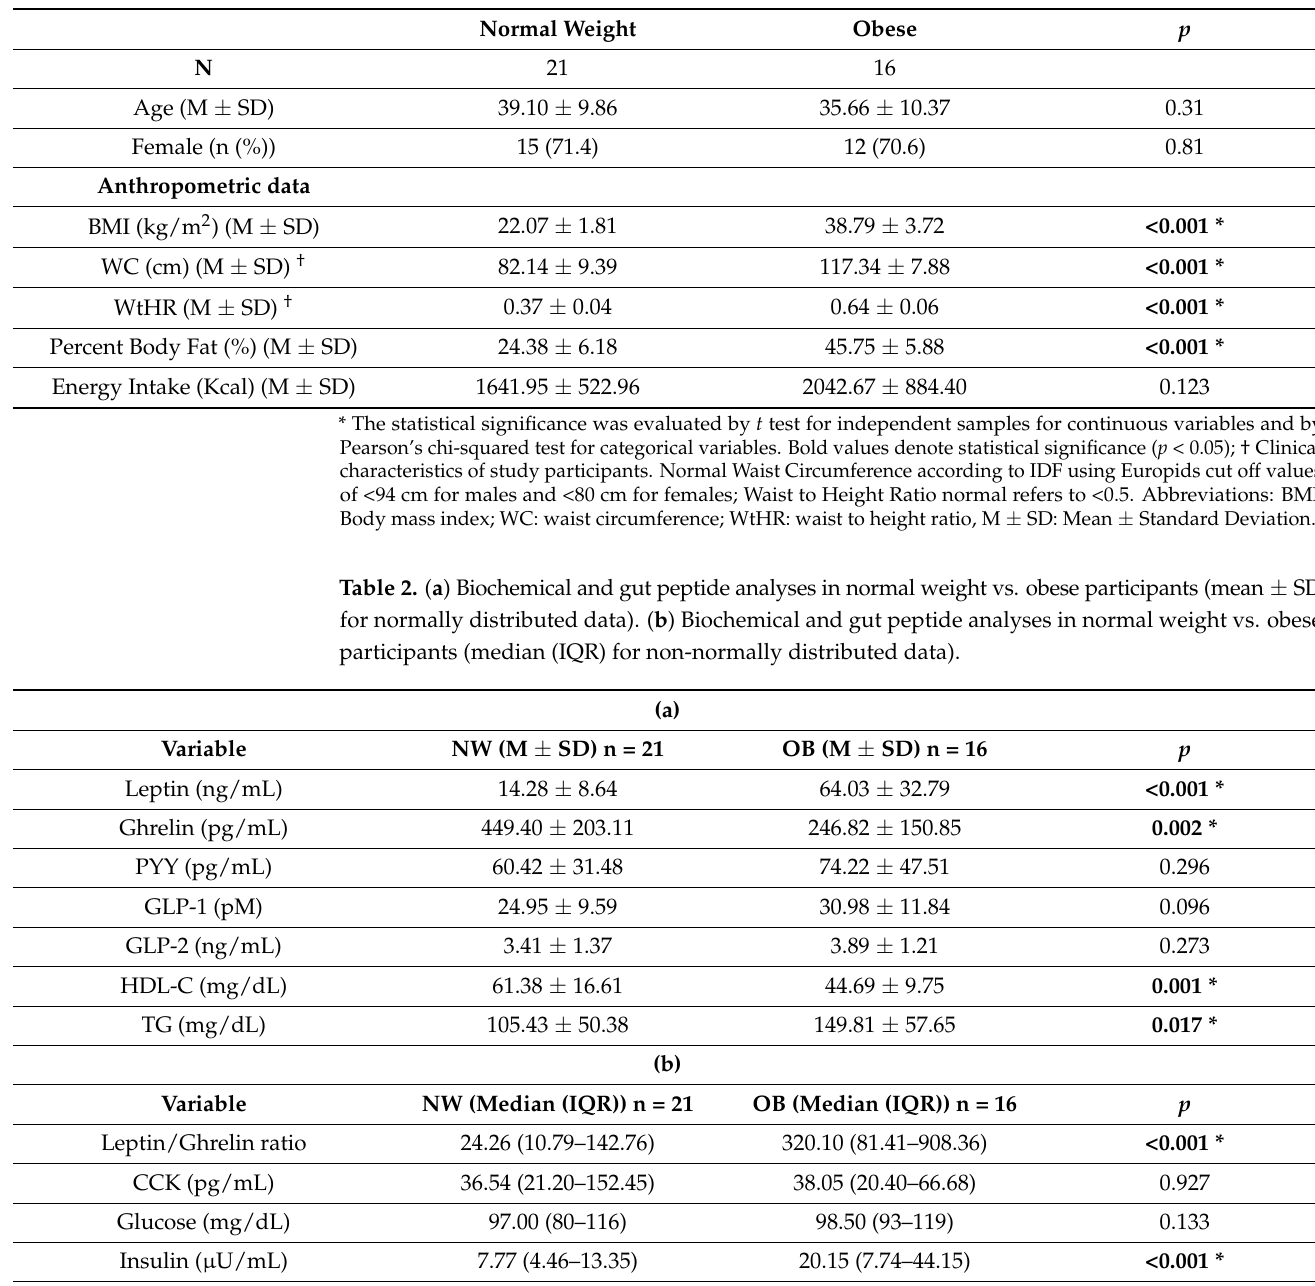
Table 1. Participant characteristics.